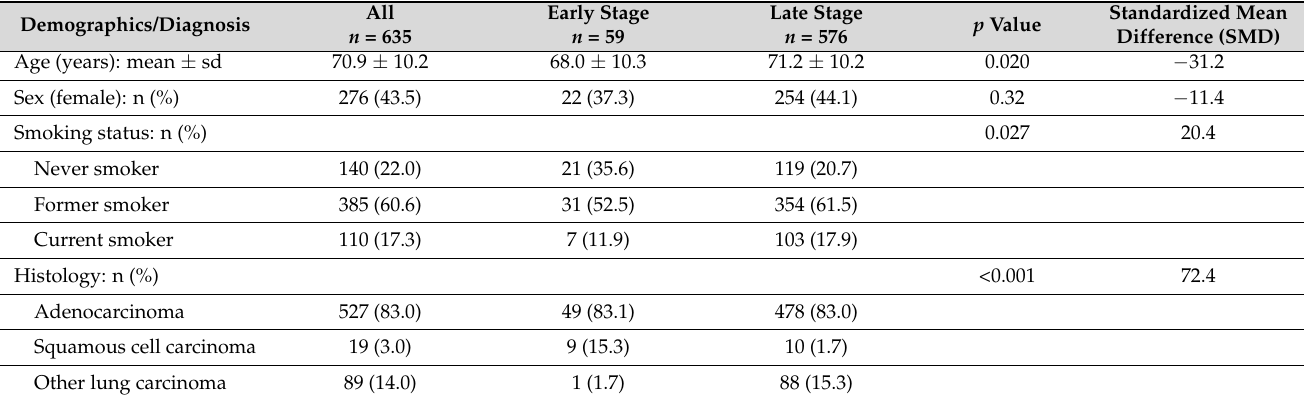
Table 1. Baseline characteristics by stage of NSCLC among all